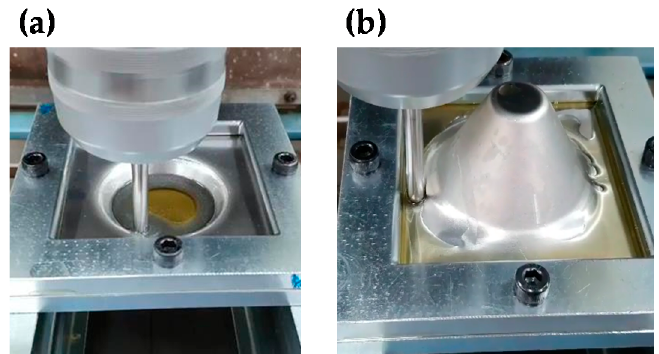
Figure 3. The incremental forming process of ( a ) first single point incremental forming (1st SPIF) and ( b ) counter SPIF.